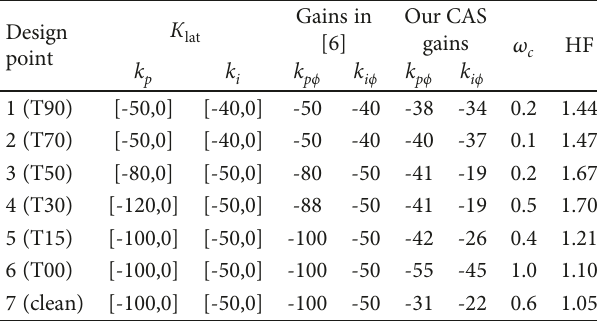
Figure 5: Block diagram for our CAS design. Table 2: Admissible CAS gain regions, CAS gains in [6], optimized CAS gains using our method and the parameters of weighting function W j ω